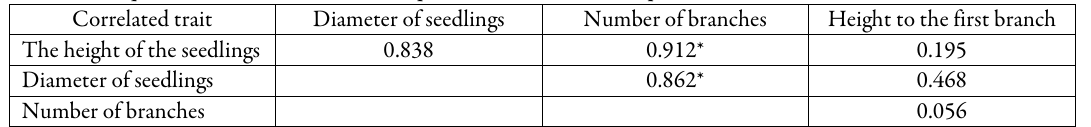
Table 6. Phenotypic correlations (r p ) between the analysed characteristics of the seedlings resulted from the R. pseudoacacia selected trees, computed for the means of all provenances Correlated trait Diameter of seedlings Number of